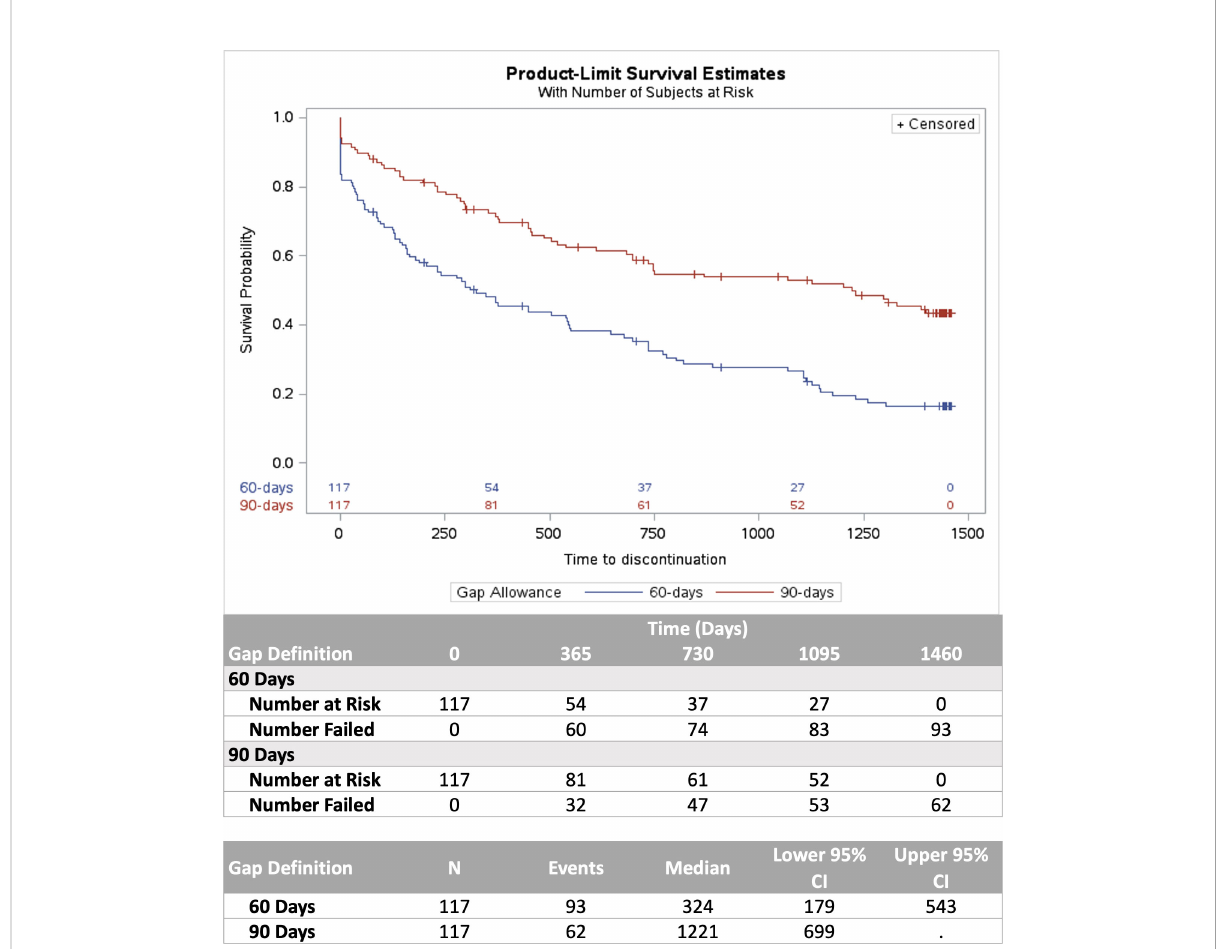
FIGURE 3 Kaplan – Meier analysis of time to discontinuation using 60- and 90-day gap de fi